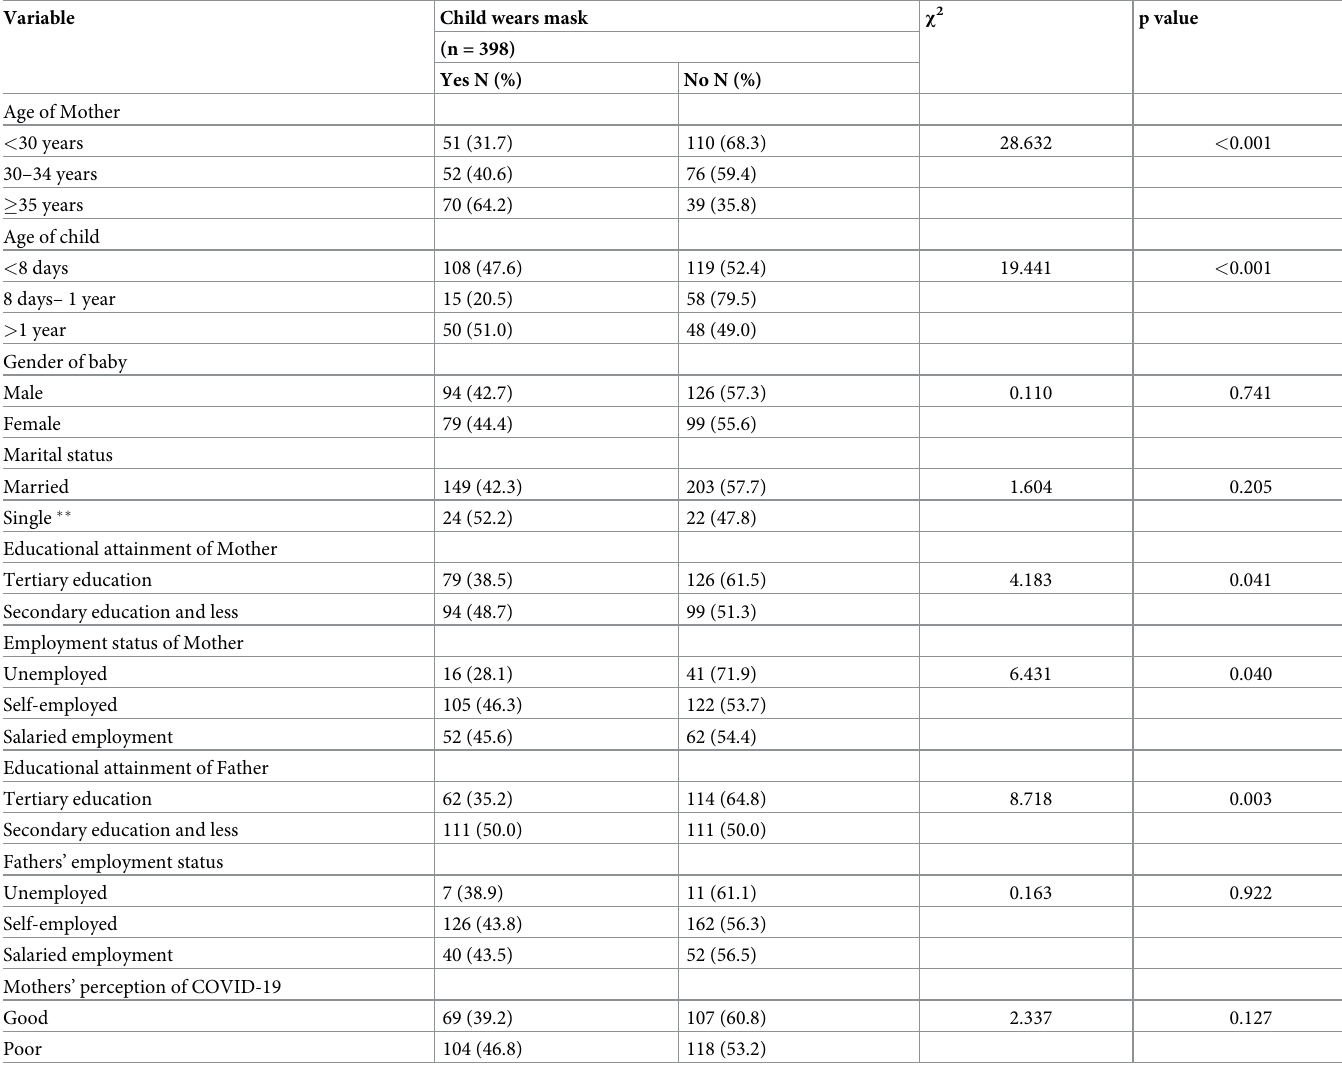
Table 2. Factors that influence the use of face masks by the